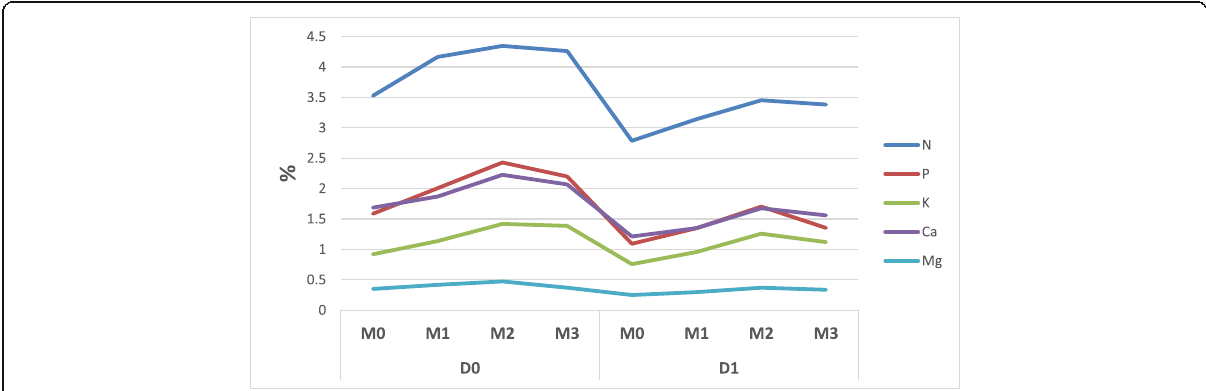
Fig. 5 Effect of melatonin (0, 50, 100, and 150 mM) on element contents of M. oleifera plants subjected to drought stress (normal irrigation and skipping two irrigation times)